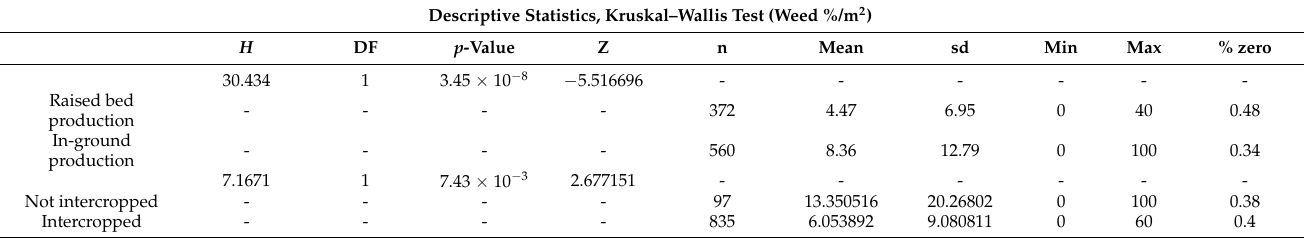
Table A3. Description of on-farm management practices. Inter-cropping Growing of two or more crops simultaneously in close proximity Using organic matter, often fallen leaves or wood chips, to cover Mulch bare soil in production areas Crop rotations Spatially shifting cultivation of particular crop families seasonally Green manure Incorporating green crop residues into the soil Method of incorporating organic matter into garden beds through Double-digging hand-tillage. The method is typically attributed to the French-intensive style of gardening. Soil management practices that reduce disturbance of soils. This technique is regionally associated with soil management practices No-till similar to those implemented at Singing Frog Farms in Sebastopol, California Table A4. Descriptive statistics, Kruskal–Wallis test (Weed %/m 2 ). Descriptive Statistics, Kruskal–Wallis Test (Weed %/m 2